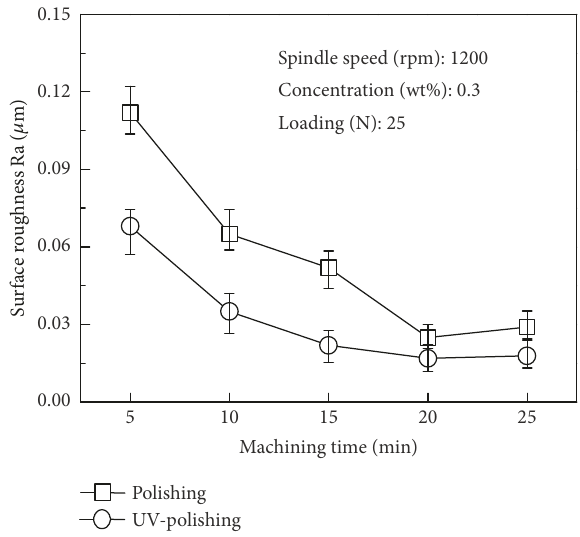
roughness and the material removal rate were observed. The experimental results were obtained as follows.